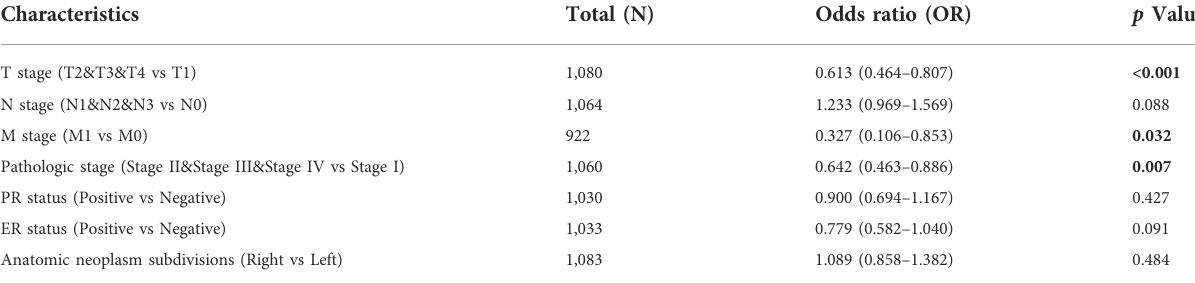
TABLE 1 The correlation between CD161 expression and clinicopathological characteristics in BC.